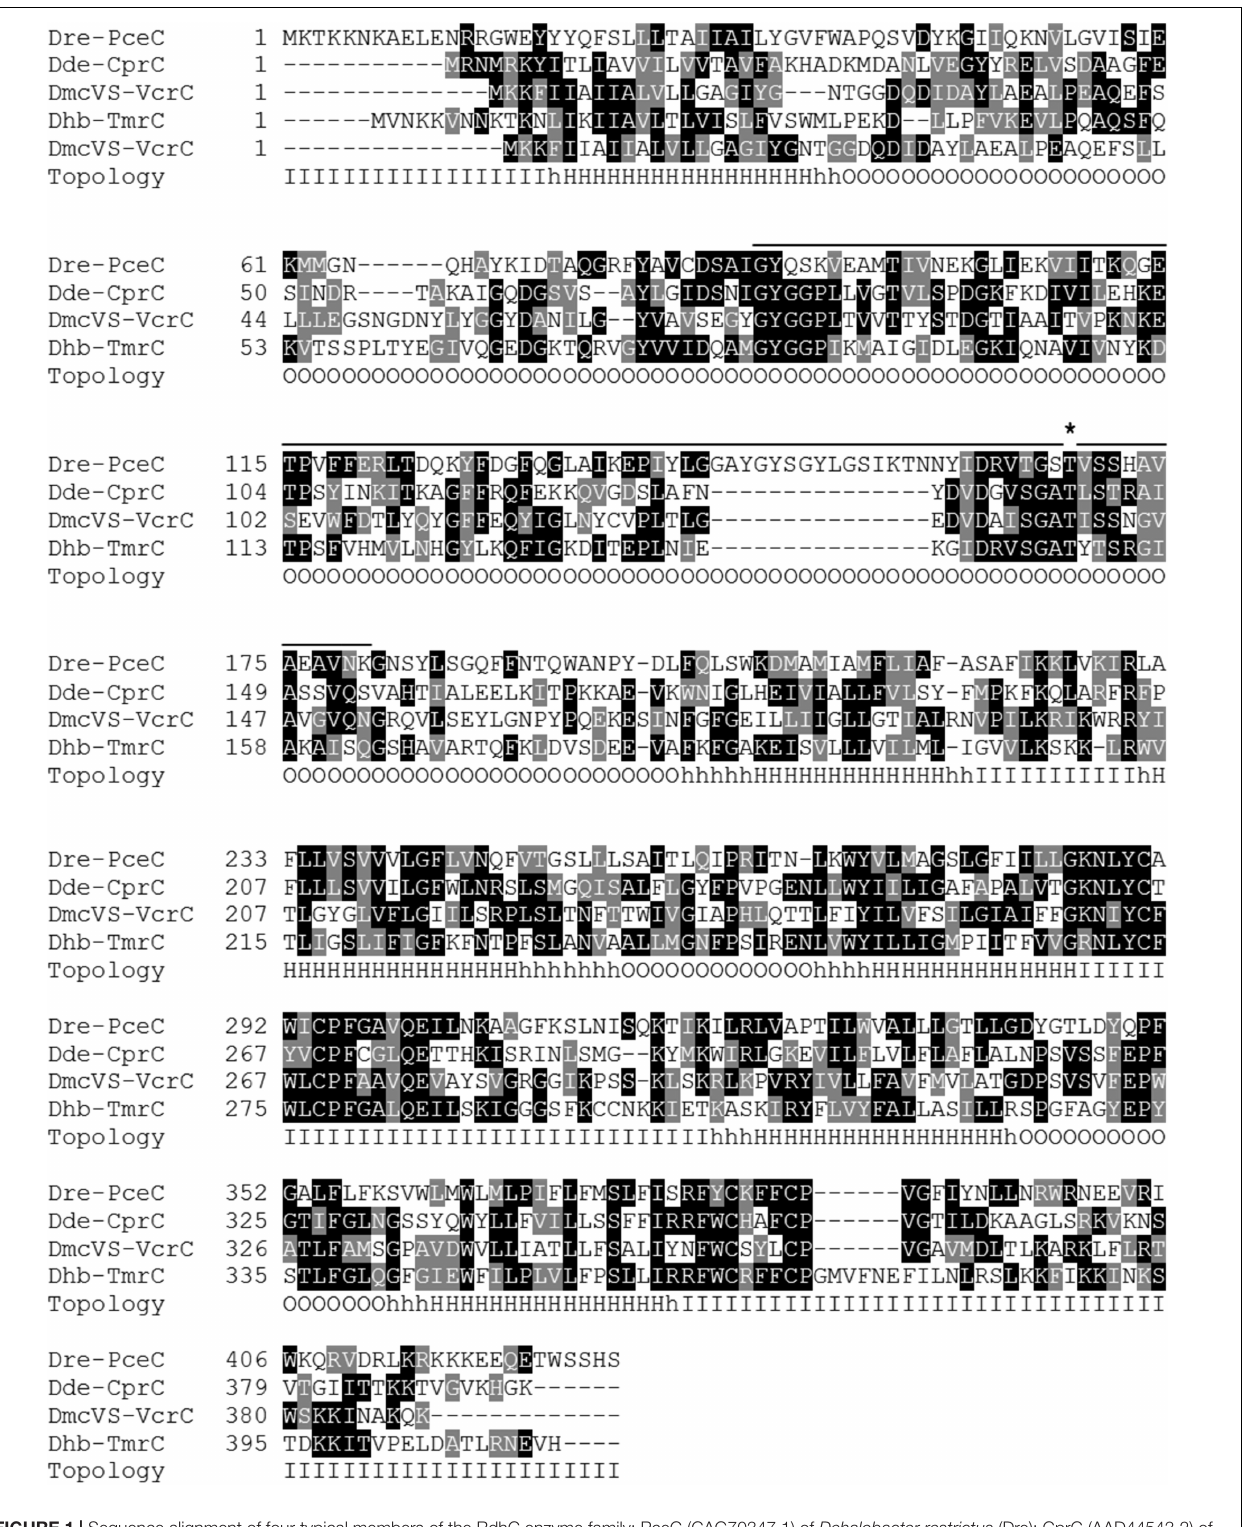
Frontiers in Microbiology |